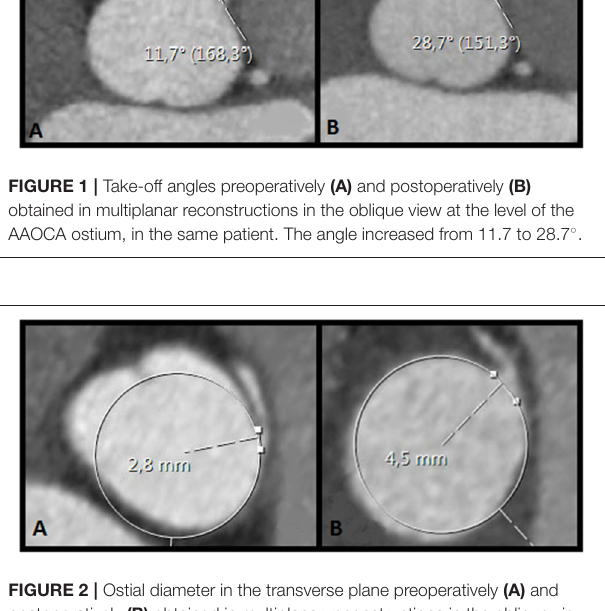
FIGURE 2 | Ostial diameter in the transverse plane preoperatively (A) and postoperatively (B) obtained in multiplanar reconstructions in the oblique view at the level of the AAOCA ostium, in the same patient. The ostial diameter increased from 2.8mm to